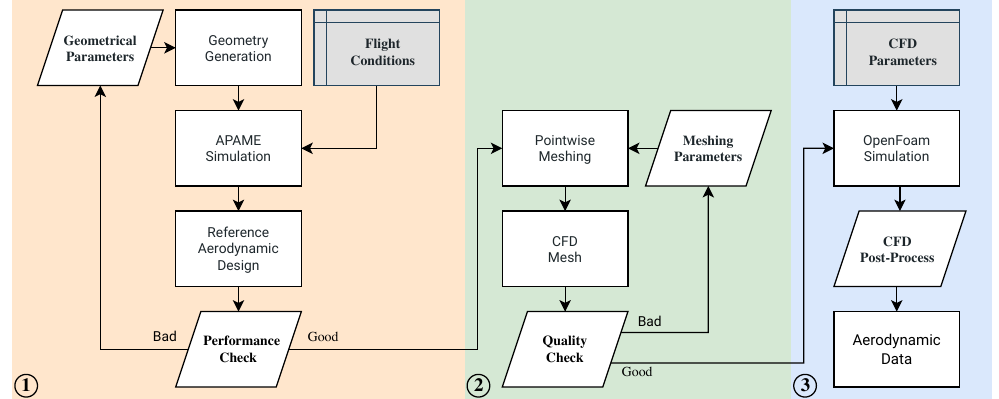
Figure 2. Flowchart of the whole (automated) toolchain. Parallelograms indicate where user inter- ference is required. Grey boxes are static inputs which do not change during the process execution. The flowchart is divided into three groups which can run independently of each other provided the required inputs are pre-defined.